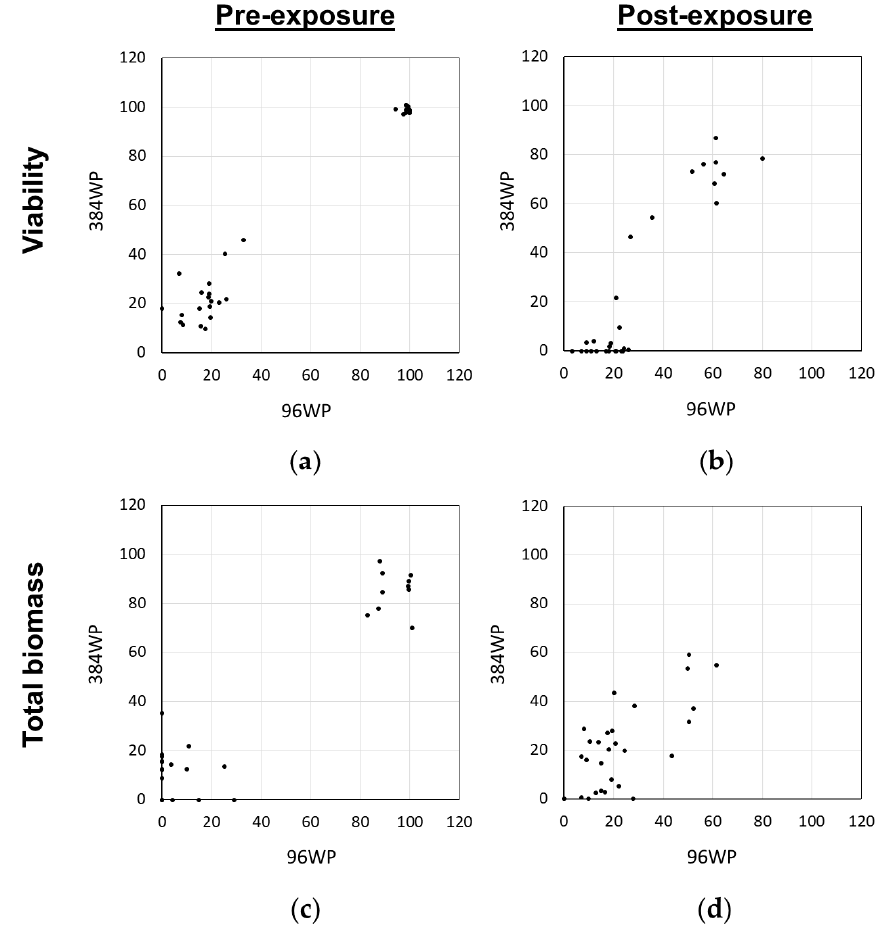
Figure 7. Correlation of the susceptibility of S. aureus biofilms to di ff erent concentrations of four antibiotics (rifampicin, oxacillin, doxycycline, penicillin G) in 96WP and 384WP in pre- ( a , c ) and post-exposure ( b , d ) modes. The e ff ect of the antibiotics on the biofilms was assessed by resazurin (“Viability”, ( a , b )) and crystal violet (“Total Biomass”, ( c , d )) staining. Results are expressed as inhibition percentages of viability or biomass in comparison to untreated biofilms and they are based on two independent biological replica experiments, with two (96WP) or eight (384WP) technical replicates for each condition.